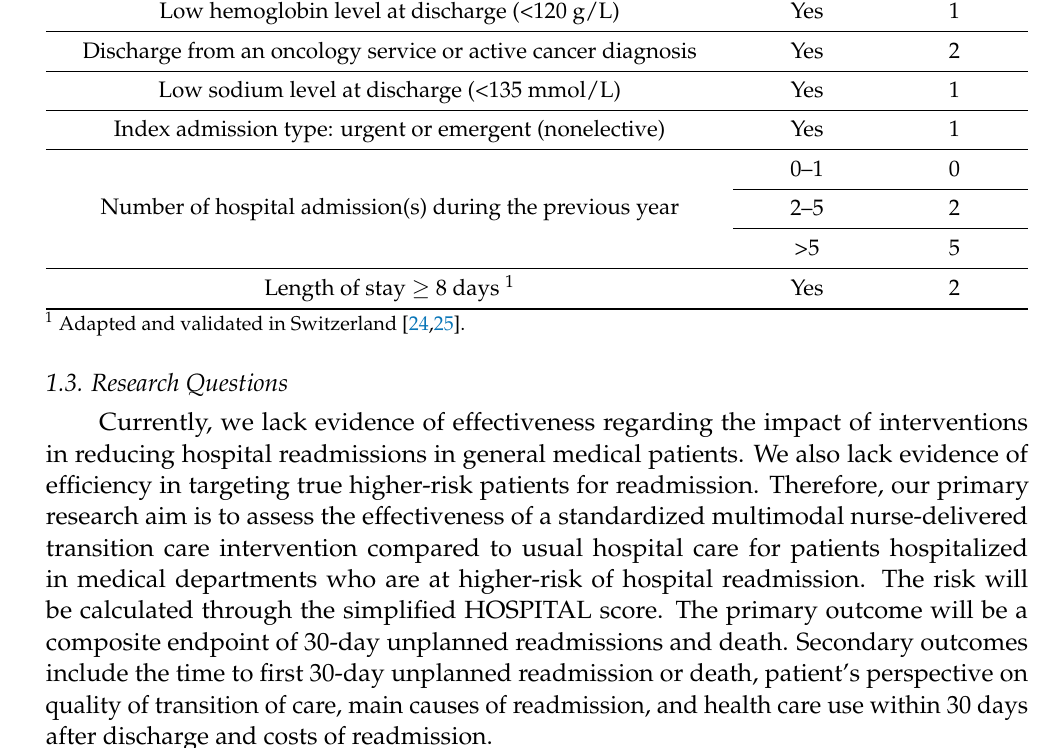
Table 1. Simplified HOSPITAL score to identify the patients at high risk for 30-day readmission. Attribute Value Points Low hemoglobin level at discharge (<120 g/L) Yes 1